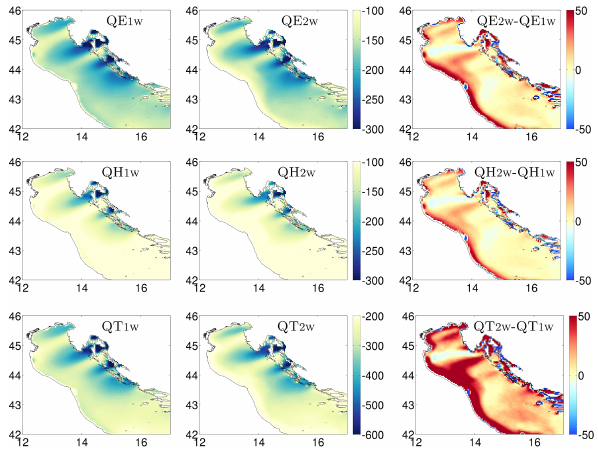
Figure 5. Mean fluxes in the Adriatic during 28 January–16 Febru- ary. First row left: mean latent heat flux Q E [ Wm − 2 ] from AL- ADIN1w. First row middle: mean latent heat flux Q E [ Wm − 2 ] from ALADIN2w. First row right: difference in latent heat flux between ALADIN2w and ALADIN1w. Second row: the same as first row, but for sensible heat flux Q H . Third row: the same as first row, but for total heat flux Q T . (Note that the fluxes are generally nega- tive during the event, implying ocean heat loss. Positive difference Q 2w − Q 1w thus means that the uncoupled system is losing more heat, while negative difference implies that the coupled system is losing more heat.)